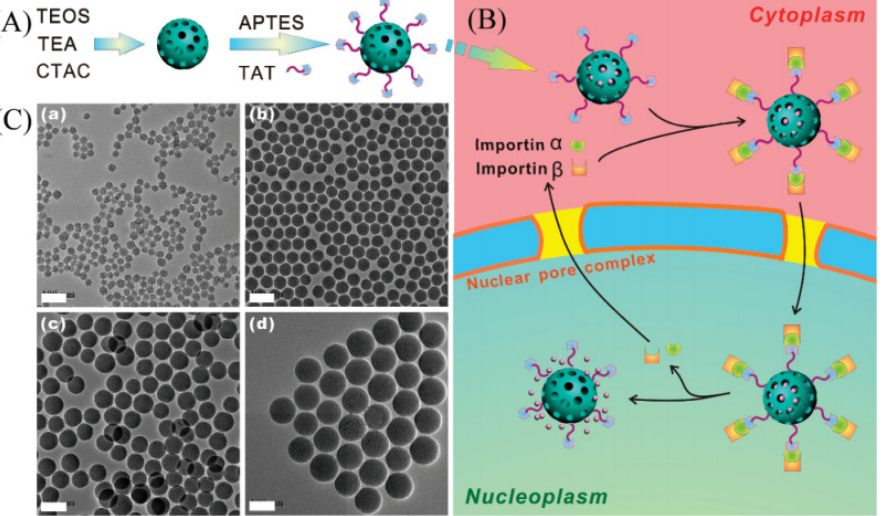
Figure 4. ( A ) Schematic diagram of the procedures for developing mesoporous silica nanoparticles. ( B ) Schematic illustration of transport of DOX-loaded particles across the nuclear membrane. ( C ) TEM images of mesoporous silica nanoparticles with sizes of ( a ) 25, ( b ) 50, ( c ) 67, and ( d ) 105 nm. Scale bars: 100 nm. Reproduced with permission from Ref. [78], Copyright 2012, American Chemical Society.